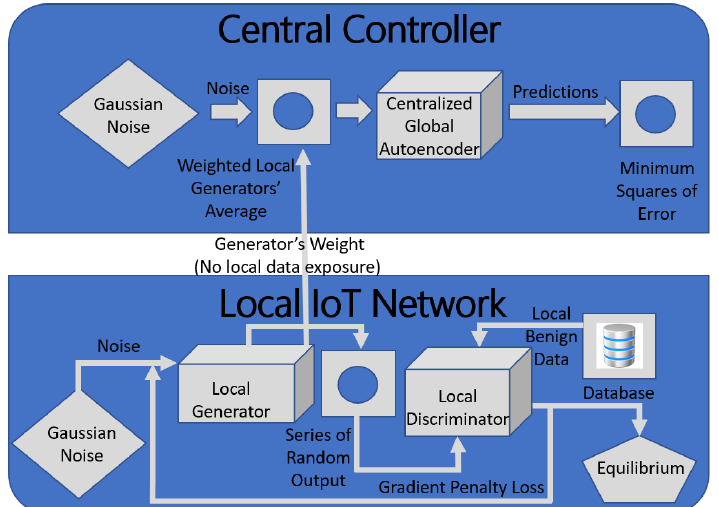
Figure 2. The Hierarchical Approach Training Map (Recreated with permission from ref. [29]. Copy- right 2022